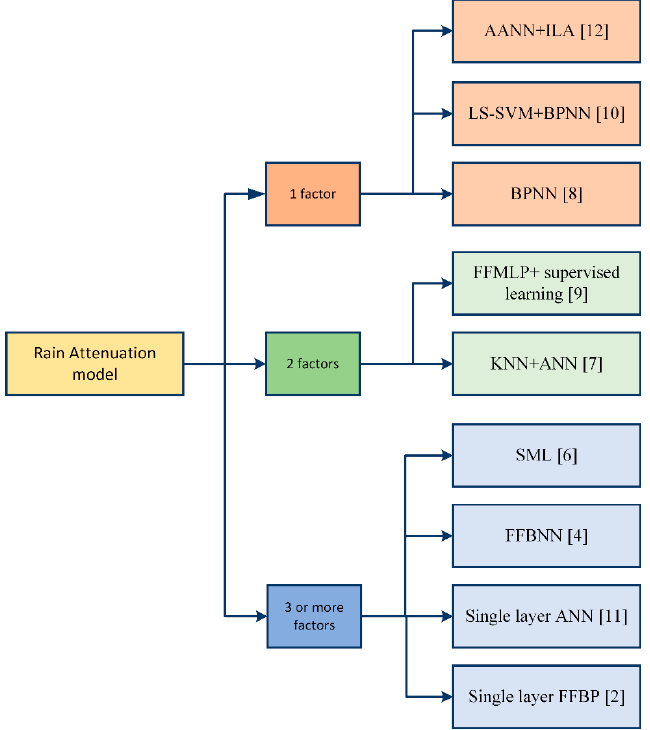
Figure 4. LARA model’s taxonomy based on the number of input parameters. Table 2. The LARA model’s input parameters.